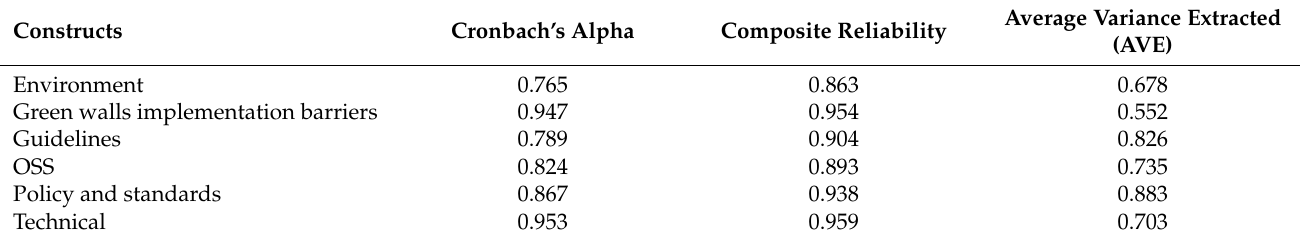
Table 3. The result of convergent validity.